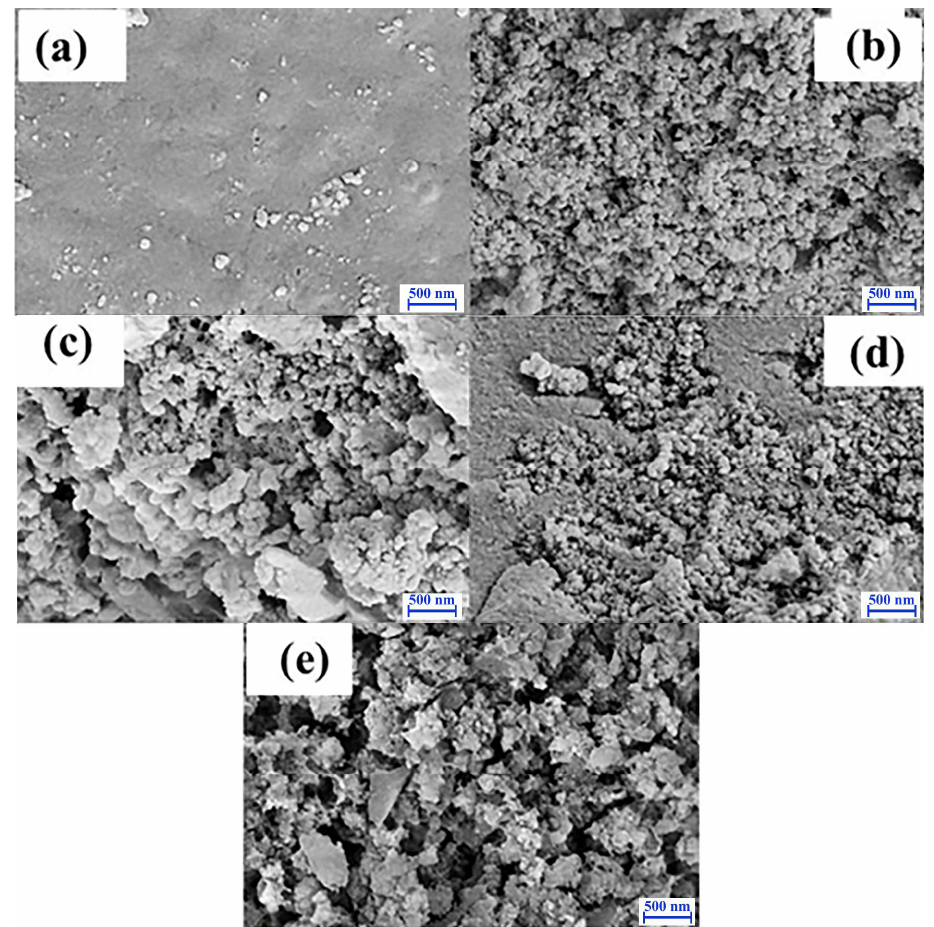
Figure 2. SEM images of MT-SiO 2 aerogels with different contents of MT polymer. MT polymer content: ( a ) 0.0100 g, ( b ) 0.0200 g, ( c ) 0.0300 g, ( d ) 0.0400 g and ( e ) 0.0500 g.